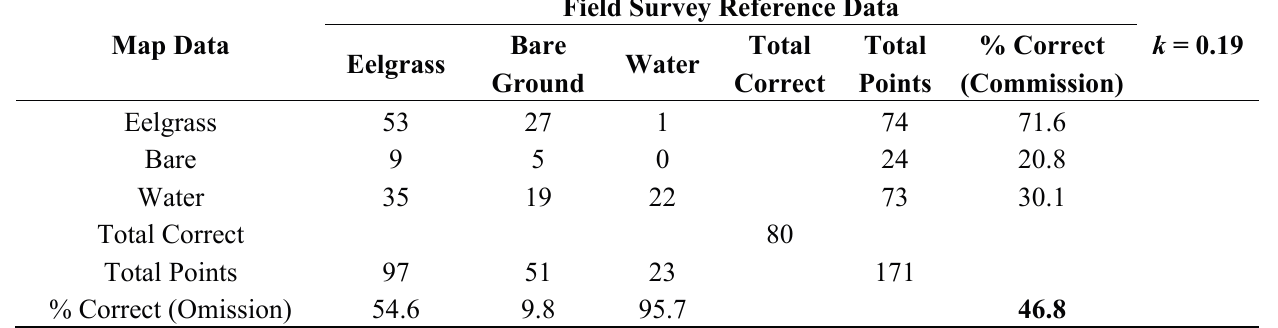
Table A12. Initial classification of habitats in Kinzarof Lagoon.